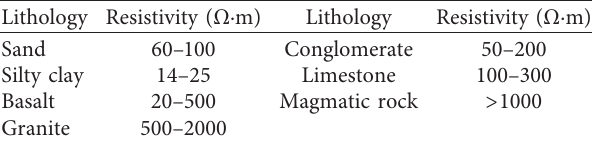
Table 1: Statistical of rock resistivity in the magmatic